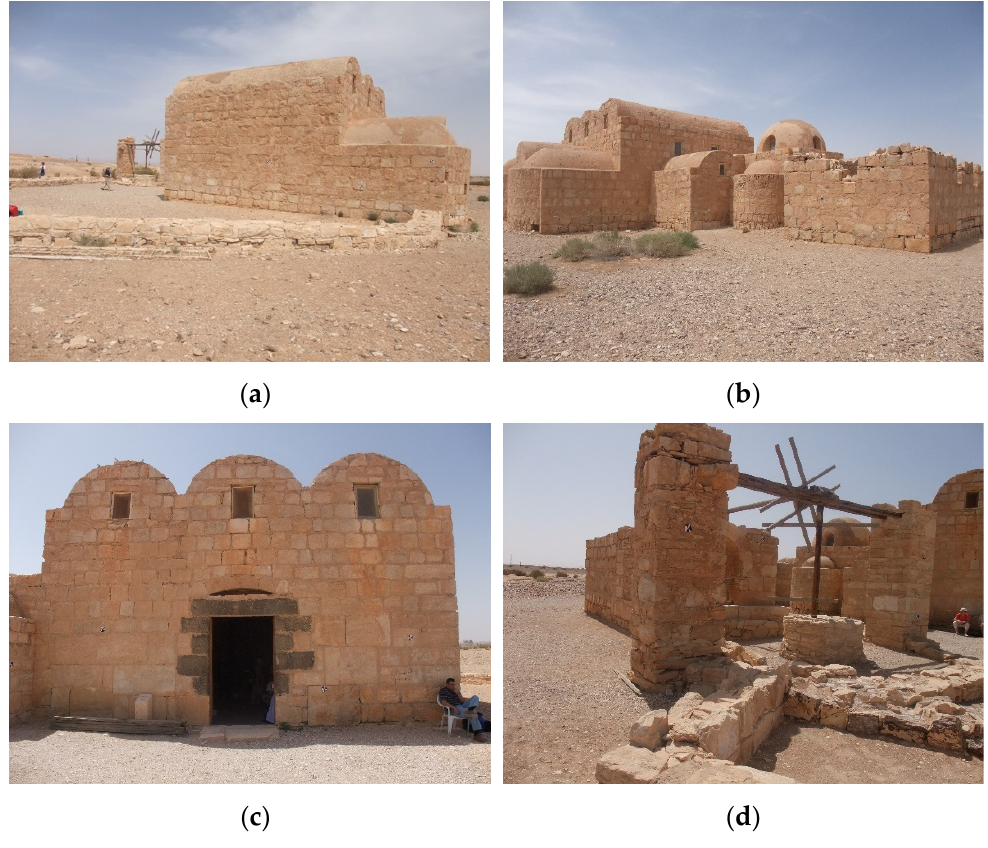
Figure 2. Qaser Amra exterior from different sides: ( a ) Southwest view (Figure 1c); ( b ) Southeast view (Figure 1c); ( c ) Entrance gate—north side (Figure 1c part A); ( d ) Main saqiya (Figure 1c part N). (Ref. Department of Antiquities of Jordan).